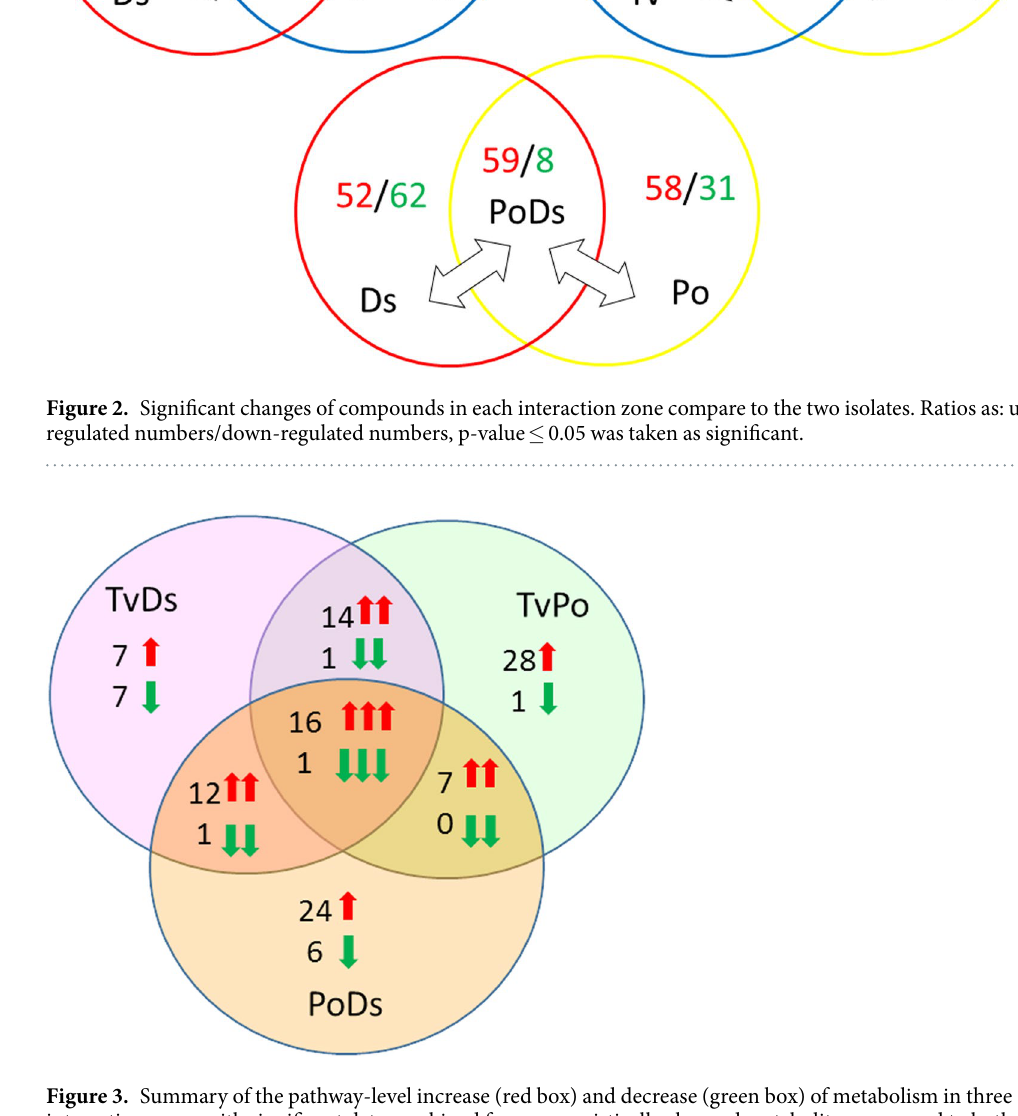
Figure 3. Summary of the pathway-level increase (red box) and decrease (green box) of metabolism in three interaction zones with significant data combined from synergistically changed metabolites compared to both isolates. Pathways in yellow and white fonts represent unique and shared pathways,